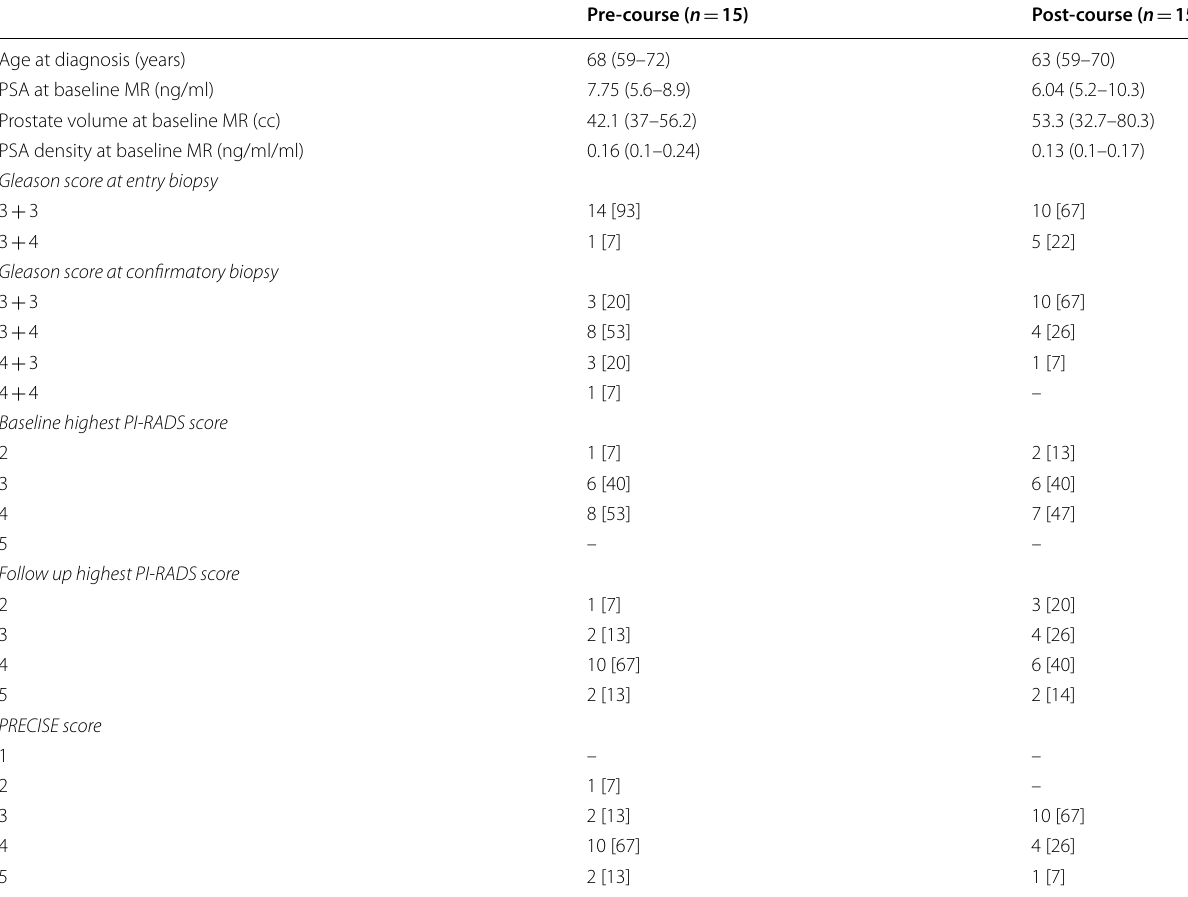
Data are medians and interquartile range (parentheses); percentages in brackets [%] PSA : Prostate Specific Antigen; MR : Magnetic Resonance; PI-RADS : Prostate Imaging–Reporting And Data System; PRECISE : Prostate Cancer Radiological Estimation of Change in Sequential